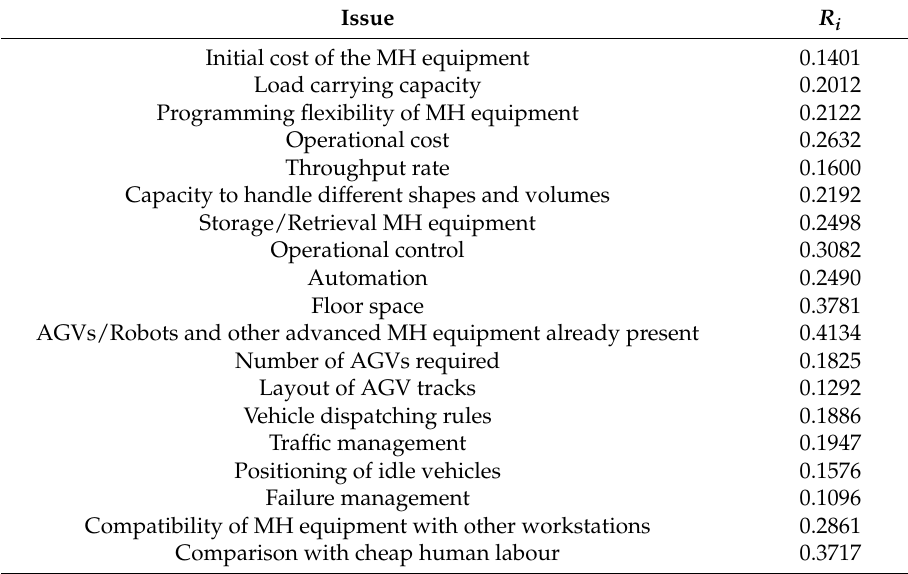
Table 25. Ratio of distance to nadir from